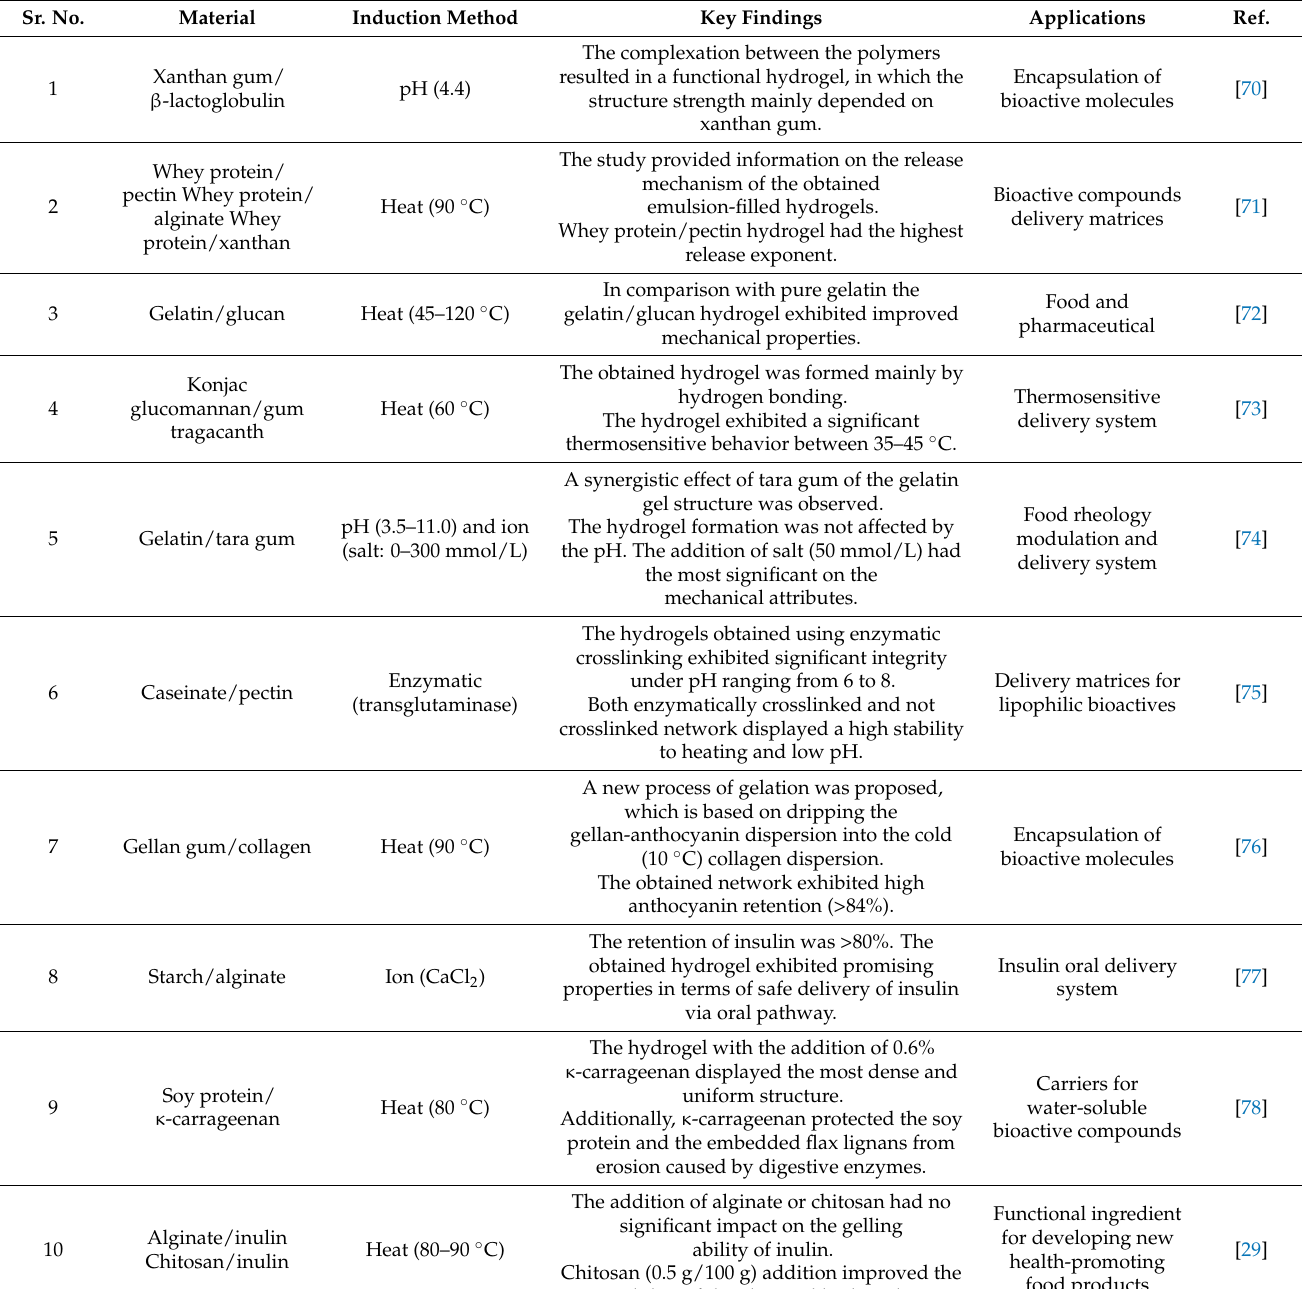
Table 1. The 10 most cited original research papers on the topic of binary hydrogels from 2012 to